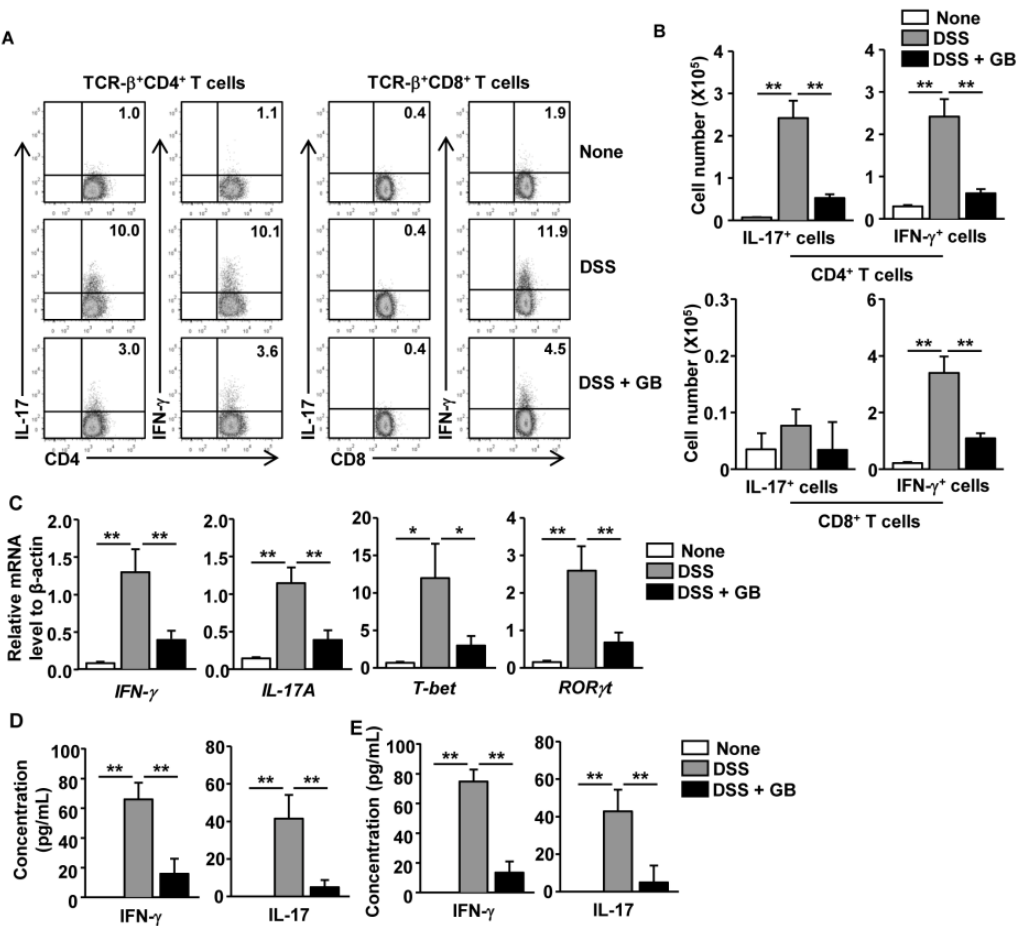
Figure 3. Ginseng berry extract (GB) suppresses Th1 and Th17 responses in dextran sodium sulfate (DSS)-treated mice. DSS (3%) was added to the drinking water of C57BL/6 mice and the mice were orally treated with GB or 0.9% saline for eight days. ( A ) Percentage of IFN- γ + and IL-17 + in CD4 + (left panels) and CD8 + (right panels) T cells, identified by gating on the TCR- β + CD4 + and TCR- β + CD8 + cells respectively, within colon-infiltrating mononuclear cells; ( B ) Means of absolute numbers of colon-infiltrating IFN- γ + and IL-17 + in CD4 + (upper panels) and CD8 + (lower panels) T cells are shown; ( C ) Real-time PCR analysis of gene expression in colon tissues; ( D ) Concentrations of IFN- γ and IL-17 in colonic homogenates were determined by ELISA; ( E ) Chronic colitis was induced in C57BL/6 mice, as described in Figure 2F, and the concentration of IFN- γ and IL-17 in colonic homogenates was determined by ELISA. All data are representative of/or the average of analyses of three independent experiments (total n = 9). Data shown are the mean ± SEM. * p < 0.05, ** p < 0.01.